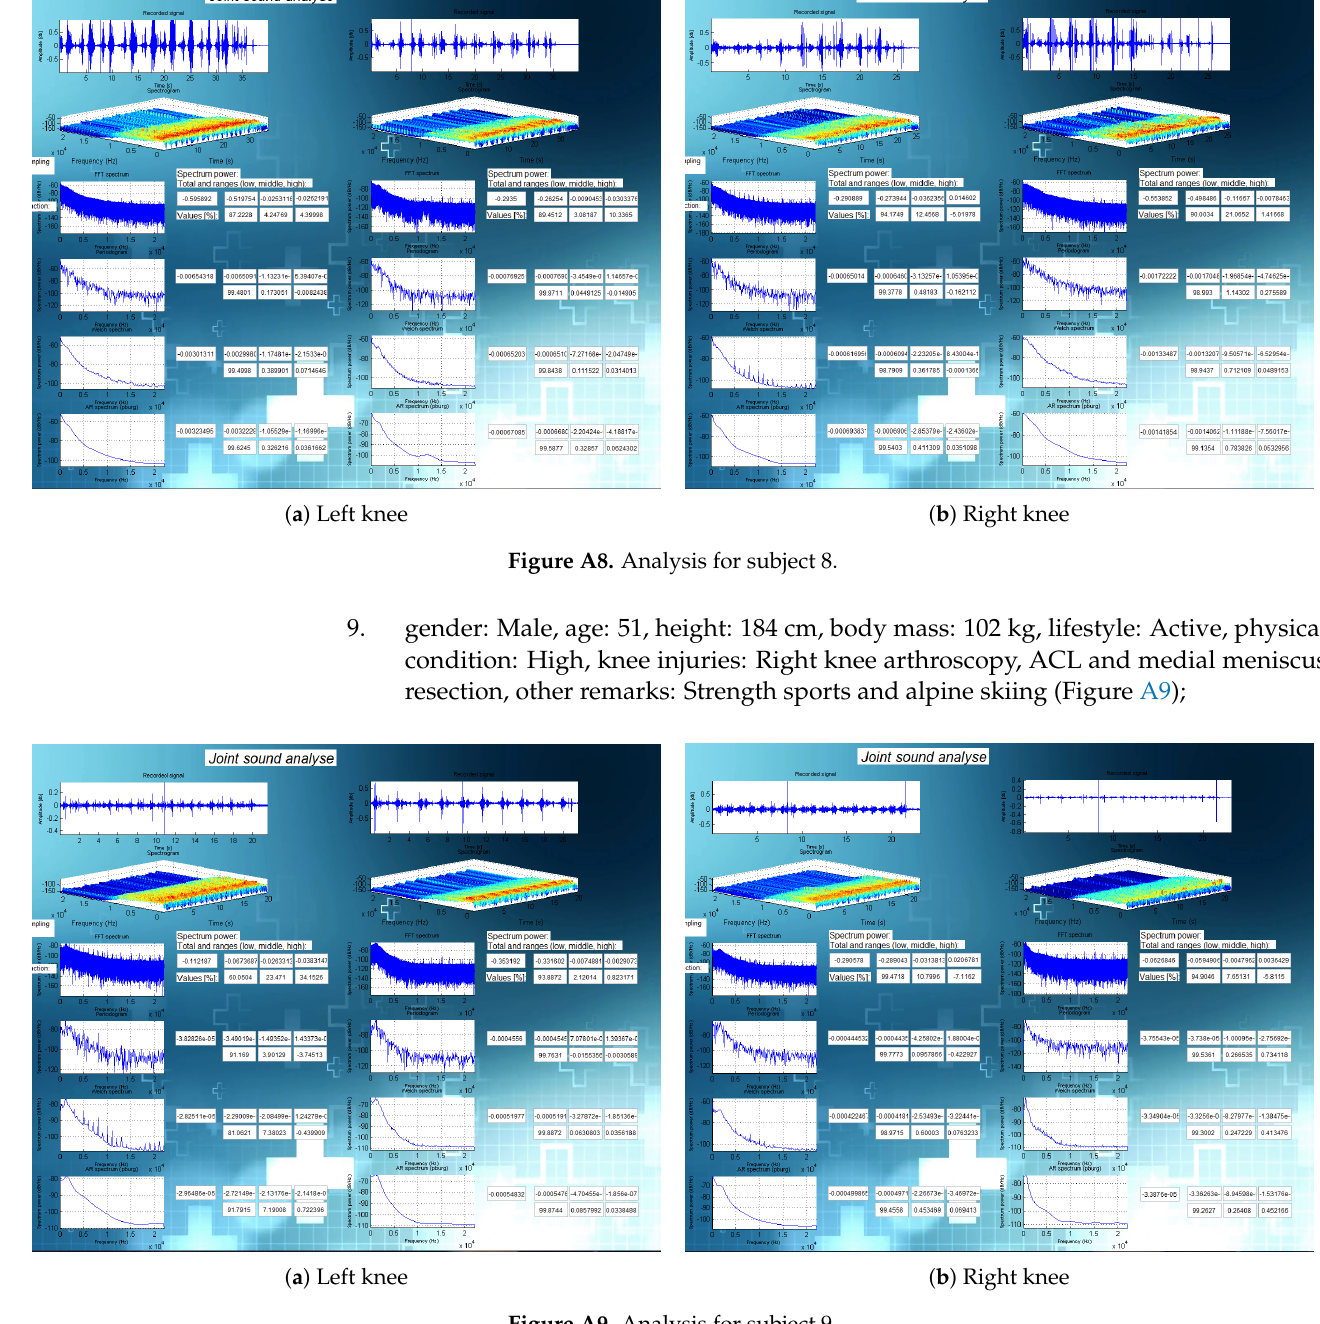
Figure A9. Analysis for subject